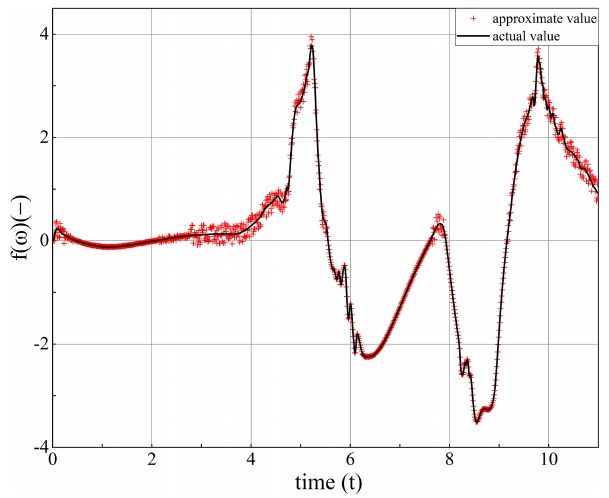
Figure 4. Comparison between actual value and approximate value.